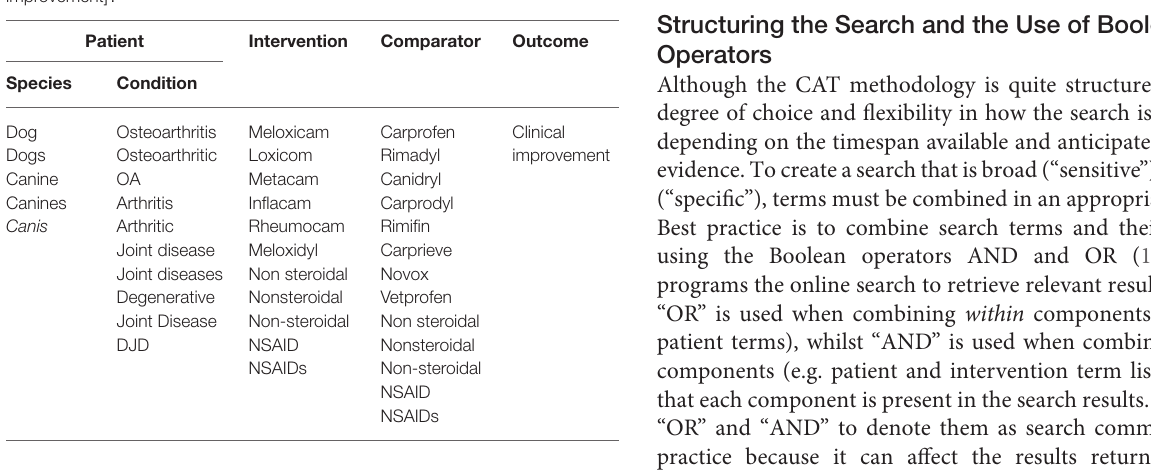
TABLE 1 | Search terms identified for the PICO question “In [dogs with osteoarthritis] does [meloxicam compared with carprofen] result in [greater clinical